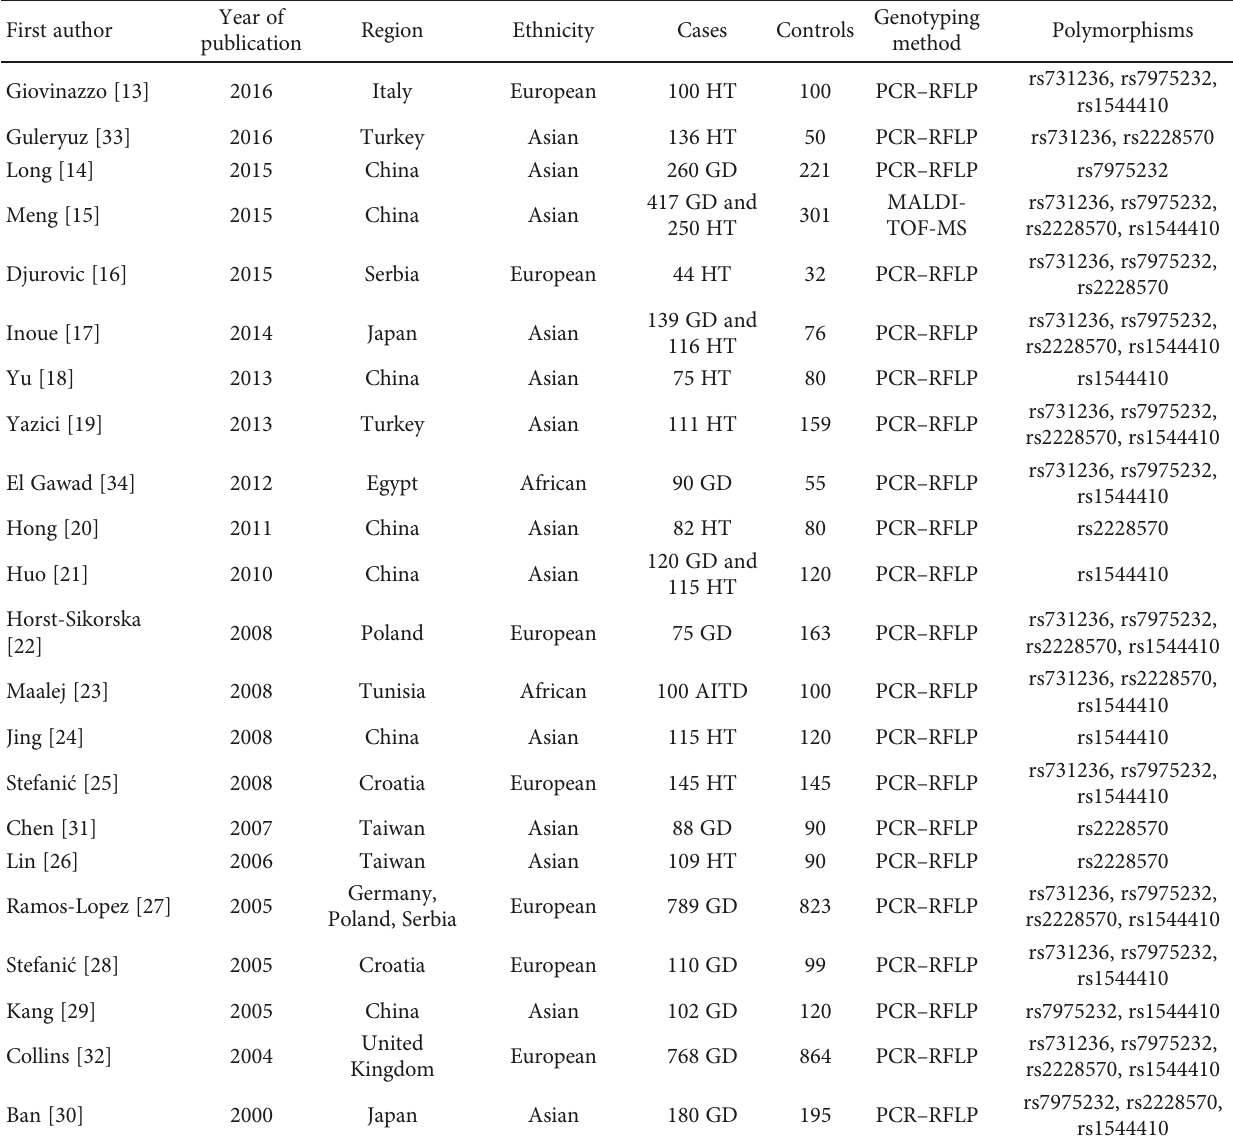
Table 1: The main characteristics of all included